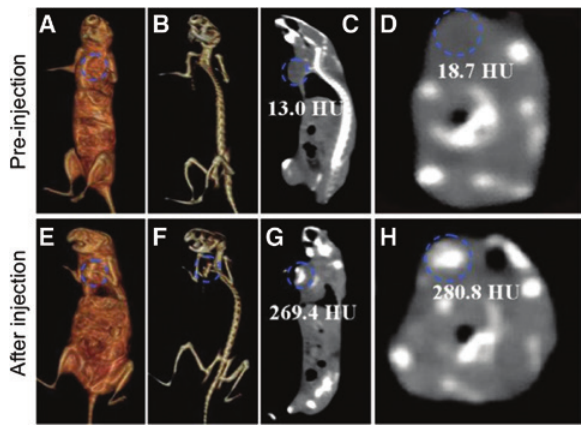
Figure 19: In vivo CT images of a tumor-bearing mouse before (A–D) and after (E–H) injection of LiLuF the tumor site.